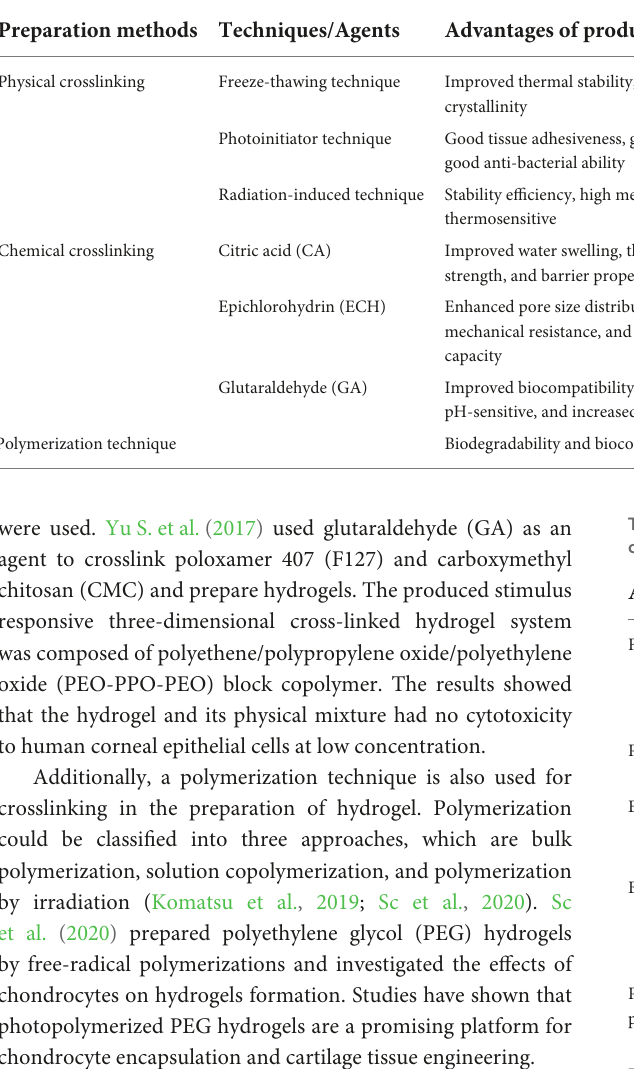
TABLE 2 Methods for cellulose hydrogels preparation.